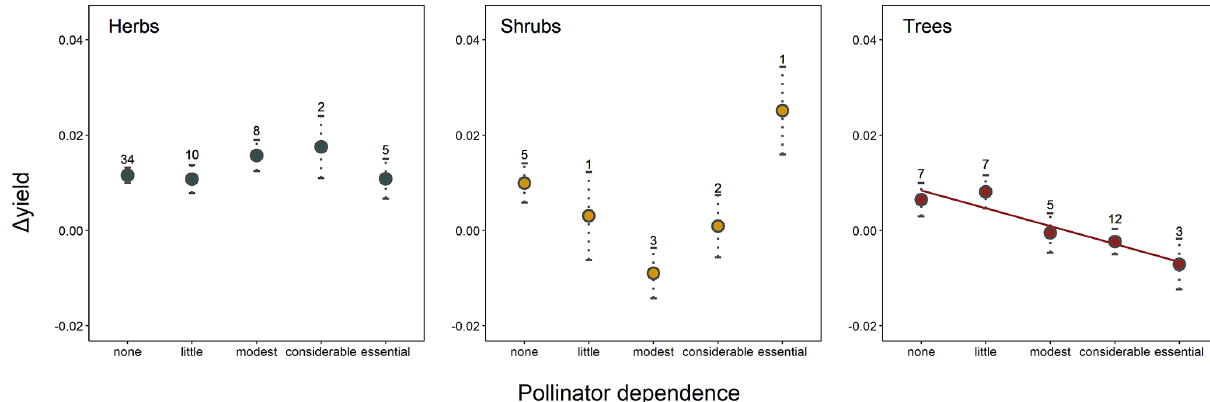
Figure 1. Joint effect of pollinator dependence and crop life form on mean yield growth ( (cid:49) yield). The single significant linear trend found (in tree crops; see results) is indicated with a regression line. Points depict model-adjusted estimated means, while dotted lines model-adjusted standard errors. Sample sizes are shown for each category. Note that (cid:49) yield is unitless (see